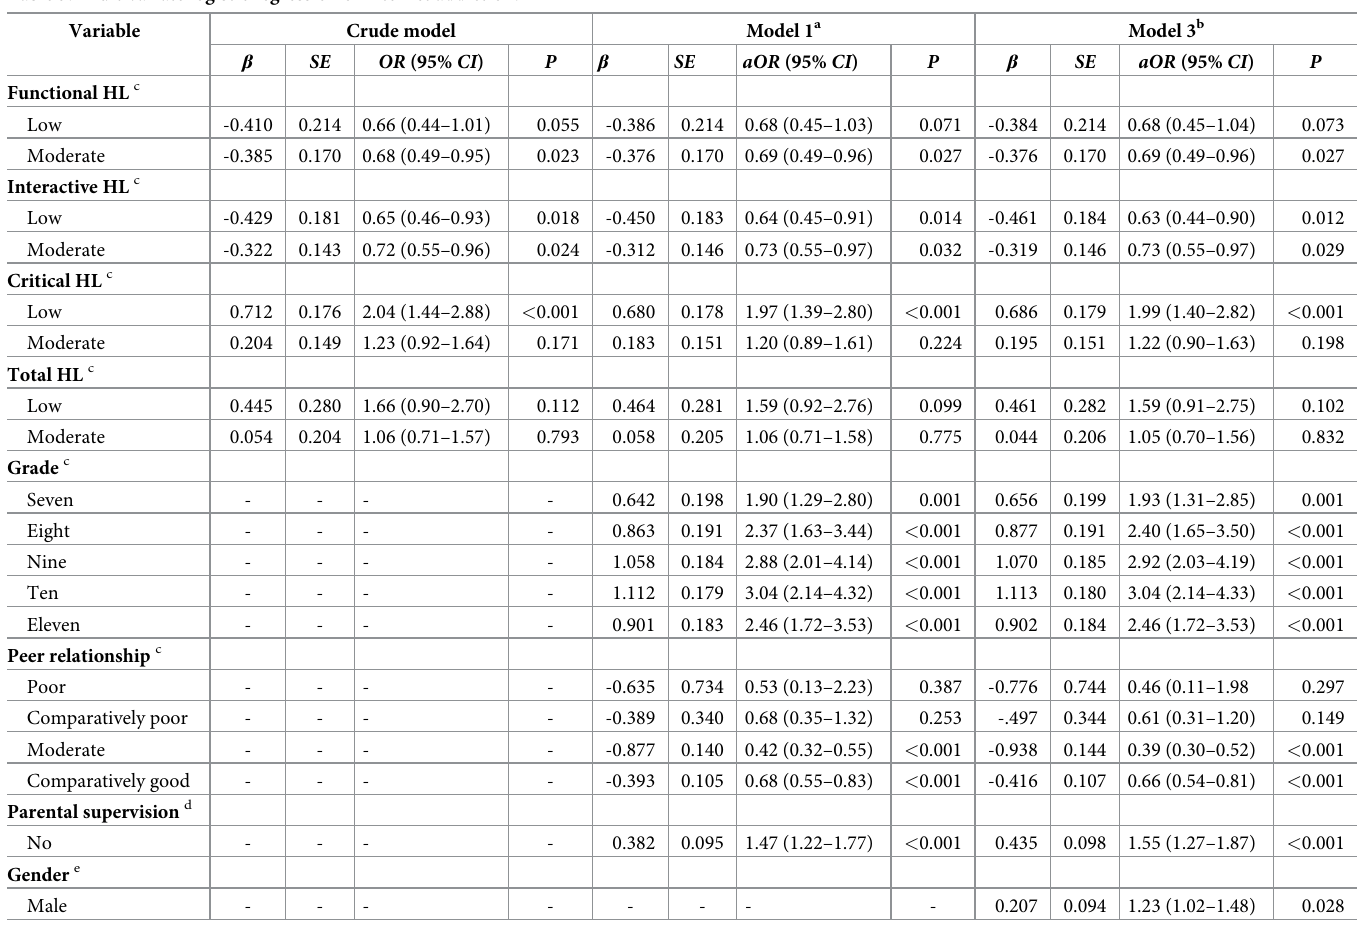
Table 3. Multivariate logistic regression of internet